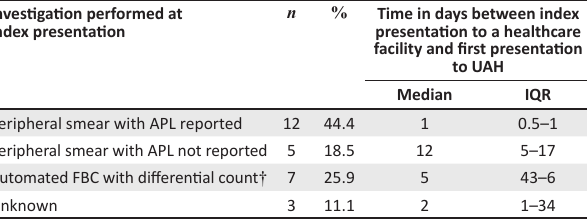
TABLE 3: Comparison of time to referral to Universitas Academic Hospital based on investigations performed at index presentation. n % Investigation performed at index presentation